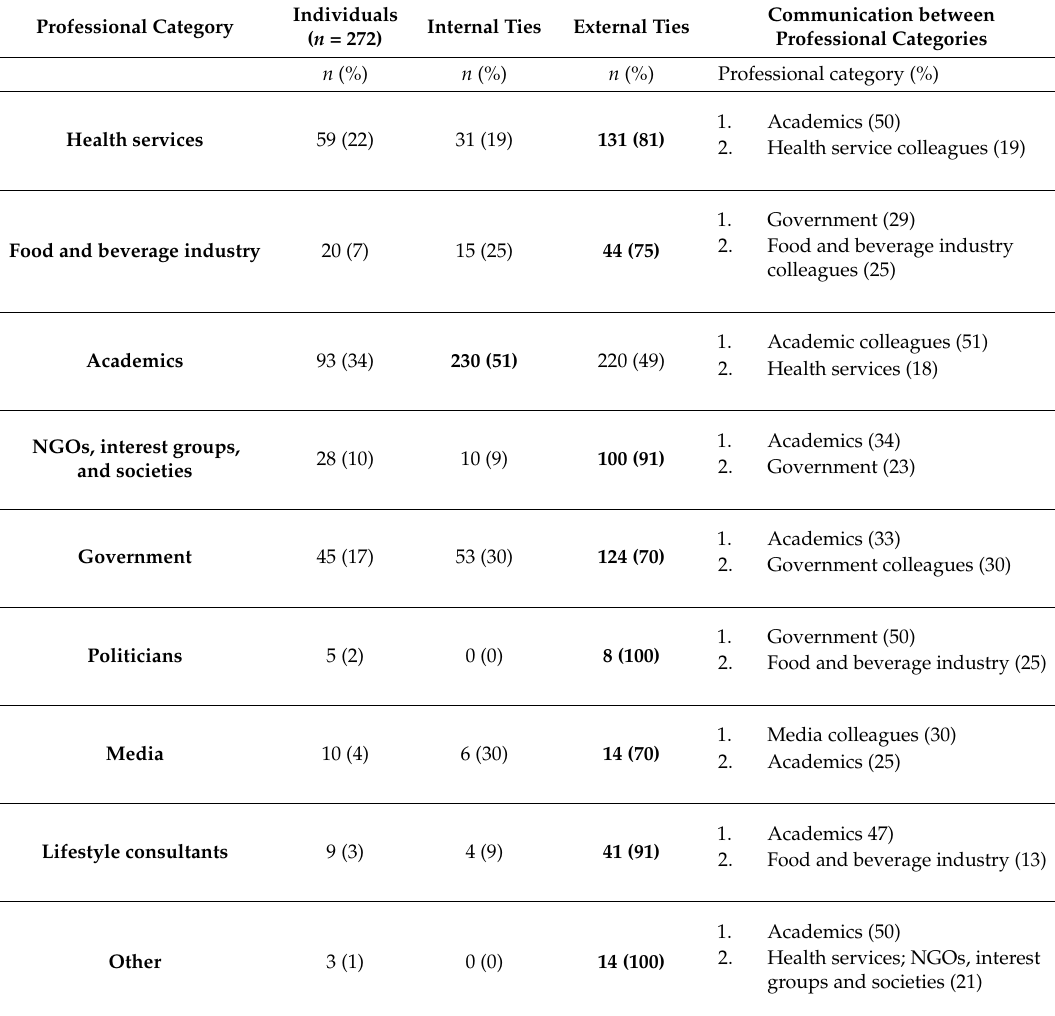
Table 1. Representation of professional categories within the network and their level of interaction (including number of individuals per professional category, number and share of internal ties and external ties, and communication between professional